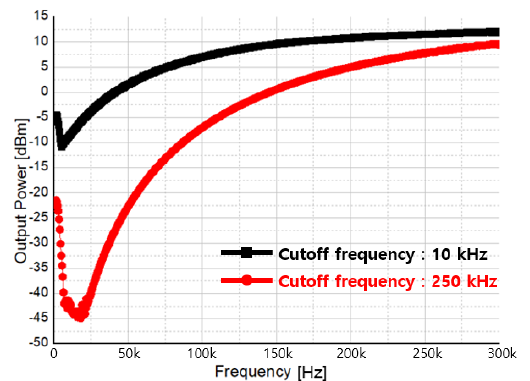
Figure 38. Measurement result of DCOC cut-off control.